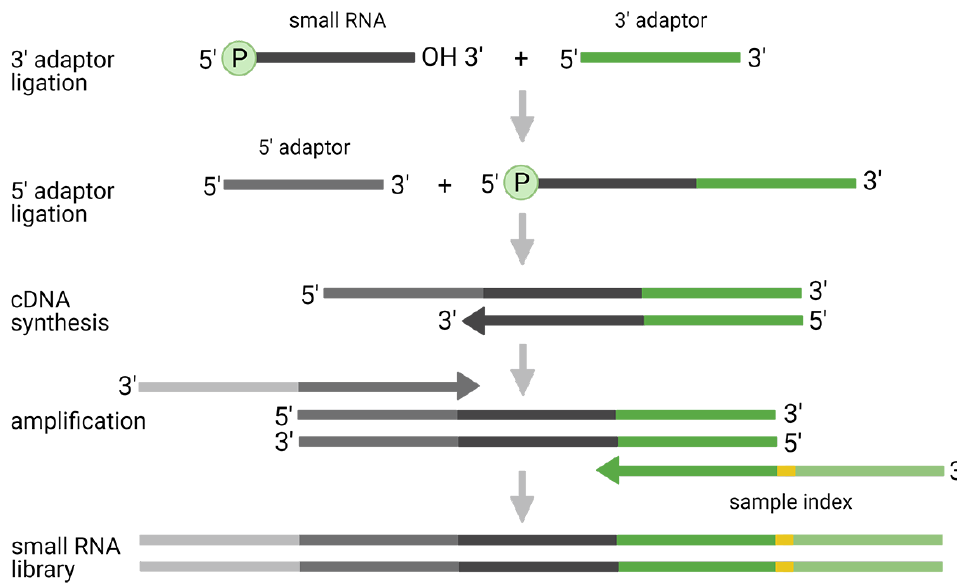
Figure 1. Original two-adaptor ligation protocol for small RNA-seq